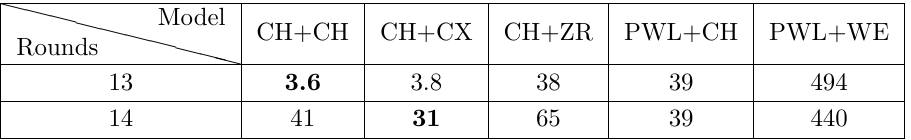
Table 6: Solving times for CRAFT over 13 and 14 rounds depending on the modeling. Timings are given in seconds, for the full solve for 13 rounds and over a subset of all cases for 14